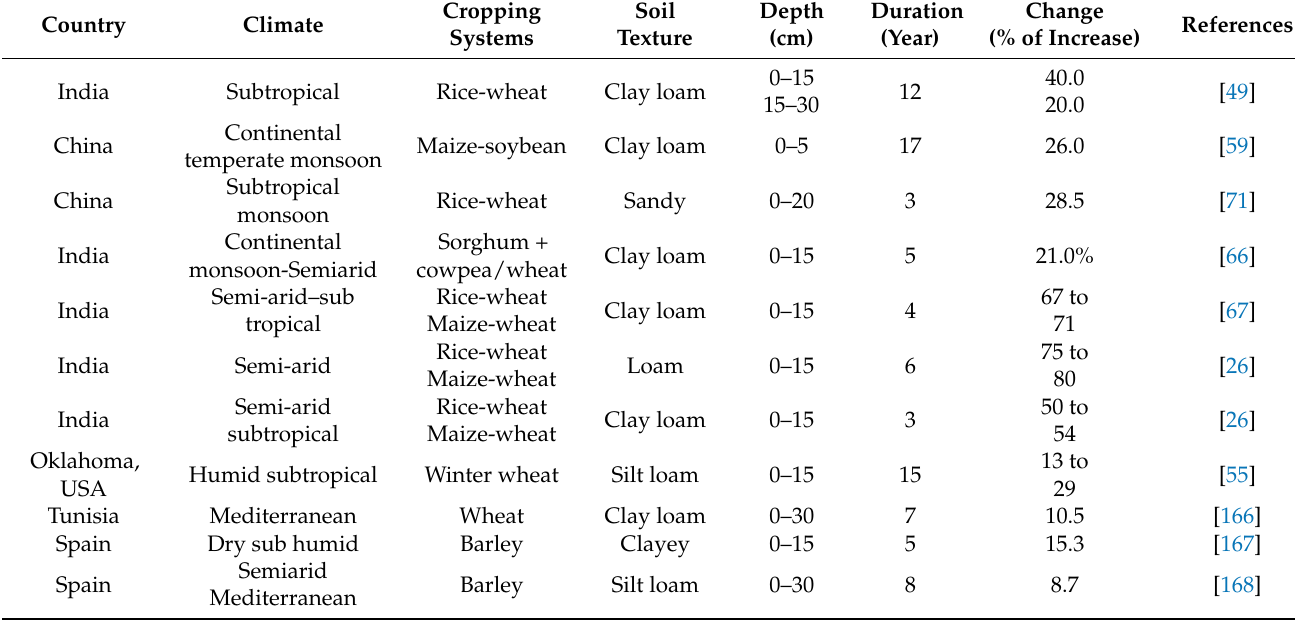
Table 1. Examples of soil organic carbon increase due to the adoption of CA-practices (Zero or minimum tillage + crop residue retention, with or without crop